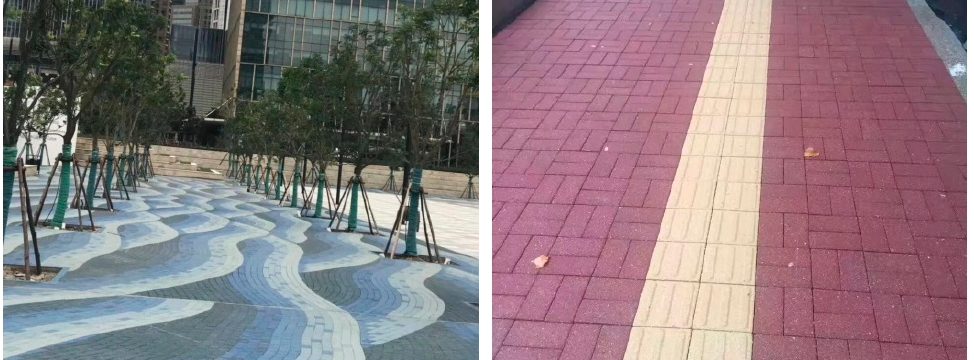
Figure 5. RM permeable brick lay in somewhere in Shandong province.